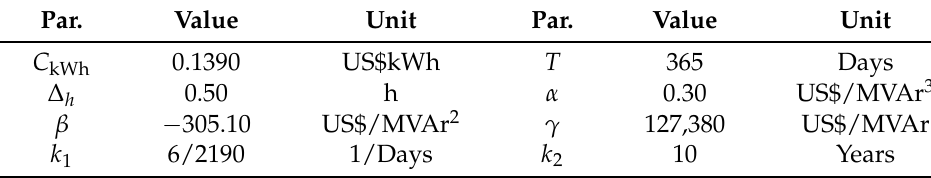
Table 4. Parameters to evaluate the component z 2 of the objective function.